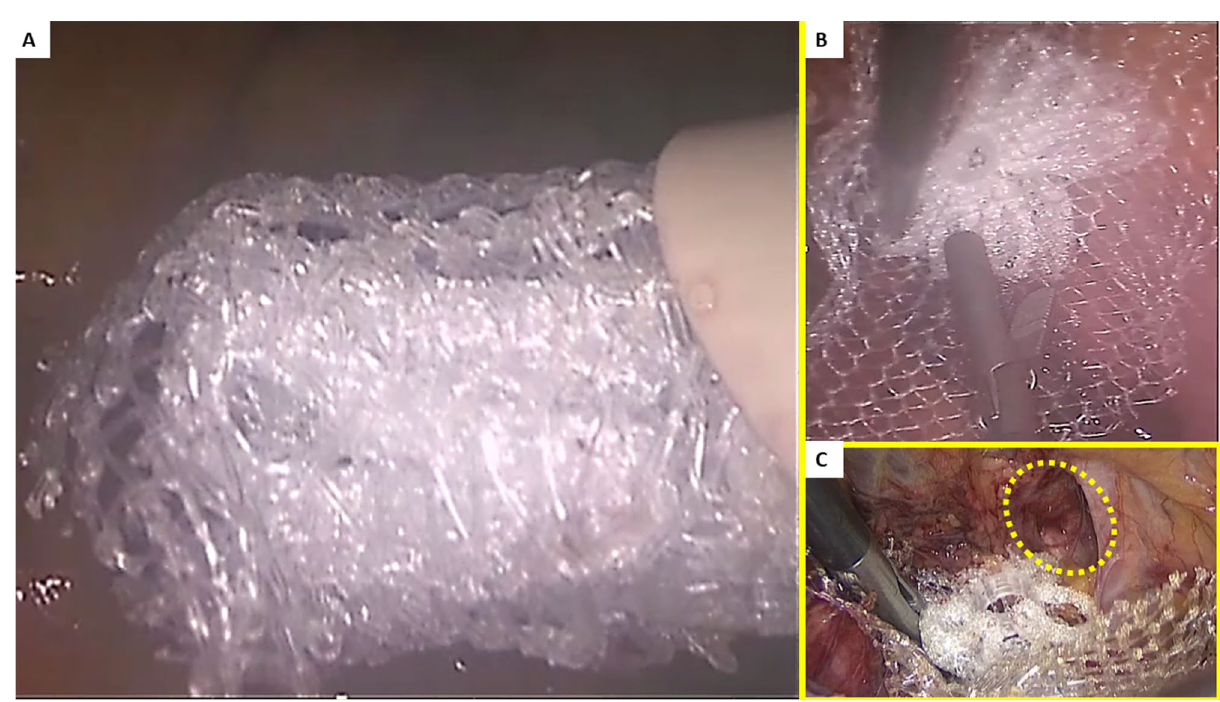
Figure 4. ( A ) The compressed 40 mm sized ProFlor E scaffold is funneled across the 12 mm large trocar channel into the abdominal cavity. ( B ) Once delivered the 3D scaffold promptly regains the original shape. ( C ) A 25 mm ProFlor E is approached to the hernial opening ready to be positioned within the defect (yellow